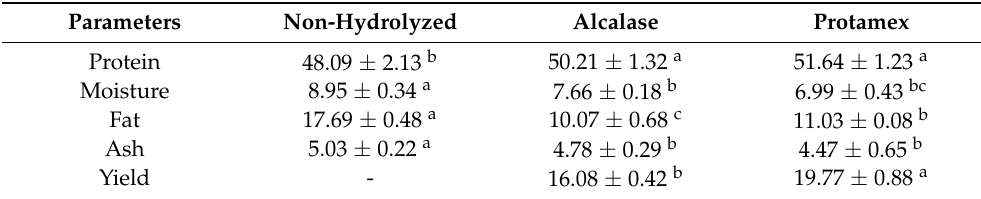
Table 1. Proximate composition of non-hydrolyzed and hydrolyzed soybean protein (%) and yield (%) (dry weight).